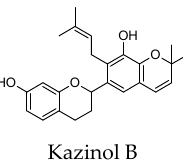
Figure 6. Structures of discussed flavan, isoflaven.